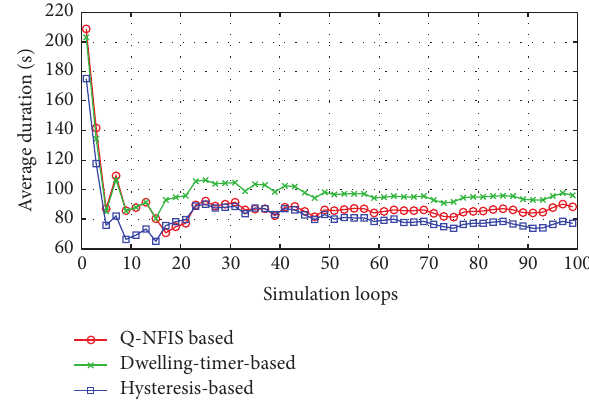
Figure 5: Comparison of average duration for 3 algorithms in first 100 simulation loops.